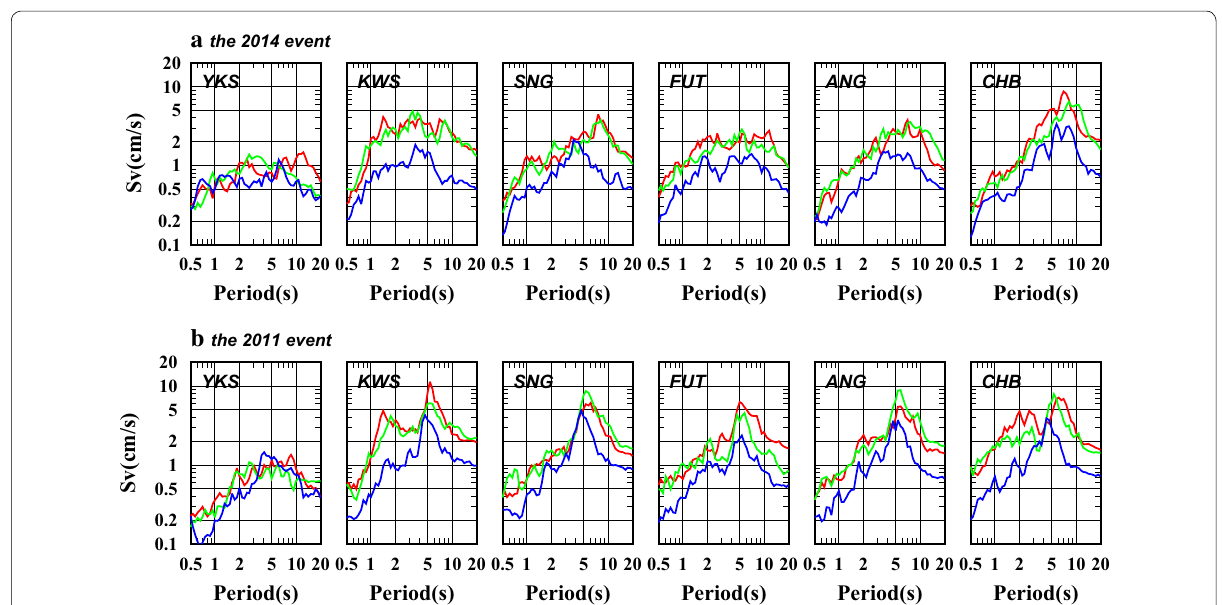
Fig. 4 Velocity response spectra with 5% damping for the Tokyo Bay area stations. b Show the spectra from the 2011 event. a Show those from the 2014 event. Red , green , and blue lines indicate the spectra for the NS, EW, and UD components, respectively. Characters in each frame indicate the station code. The location of each station is shown in Fig. 2